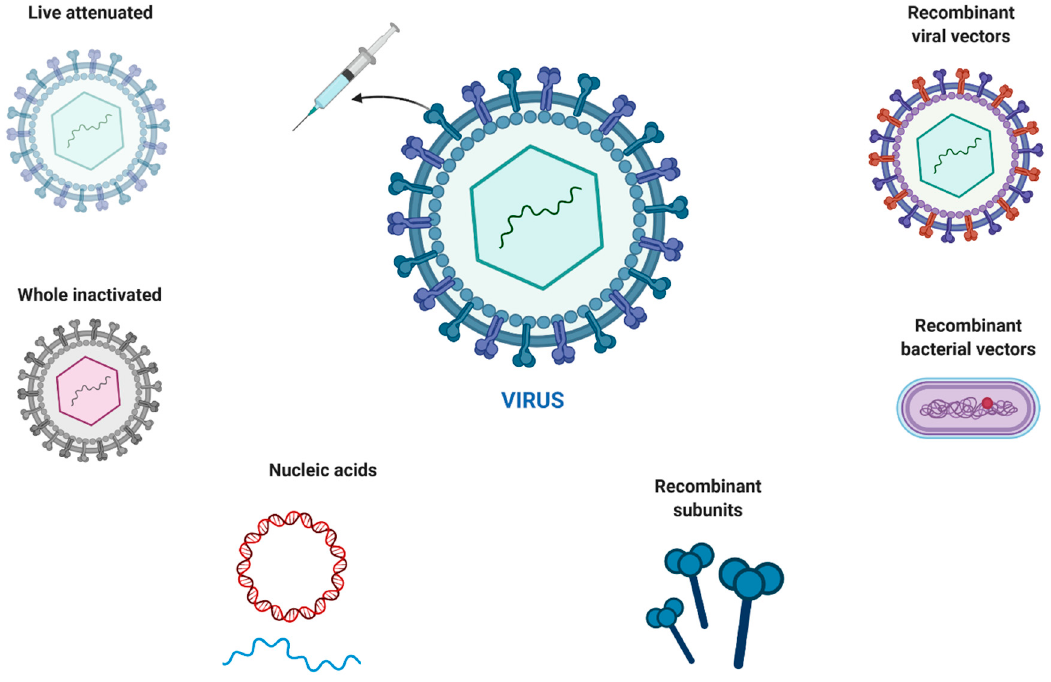
Figure 1. Commonly used strategies for vaccine development (created using BioRender).